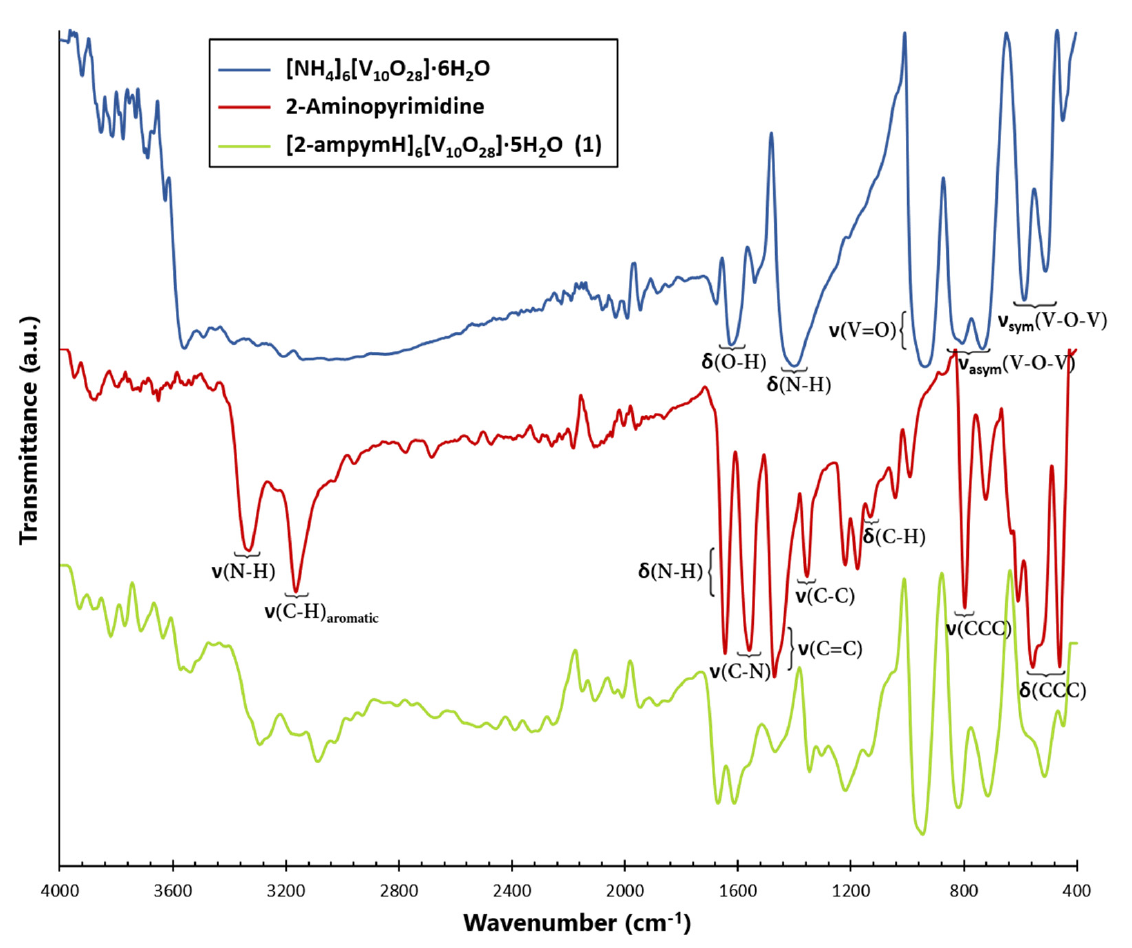
8 of 21 Figure 5. View of the supramolecular structure along the crystallographic a -axis, where all hydrogen bonds forming in Compound 1 can be observed (blue dashed line). Vanadium atoms are repre- sented in green. 2.2. Infrared (IR) Spectroscopy At the top of the 2-ampym ligand spectrum (Figure 6) were the characteristic bands at 3331 and 3165 cm − 1 that belong to the stretching vibration modes of the N-H and C-H bonds, respectively. In addition, the bending vibration modes appeared at 1645 and 1128 cm − 1 , respectively. Lower wavenumbers show the characteristic bands of the aromatic py- rimidine ring with peaks at 1556, 1469, 1356, 794, and 555 cm − 1 , belonging to the C-N, C=C, C-C, and CCC bonds, respectively [47–49]. As for the spectrum of Compound 1 , it was possible to see both characteristic bands of the ligand 2-aminopyrimidine and the bands belonging to the different vibration modes of the V-O bond of decavanadate anion. Alt-